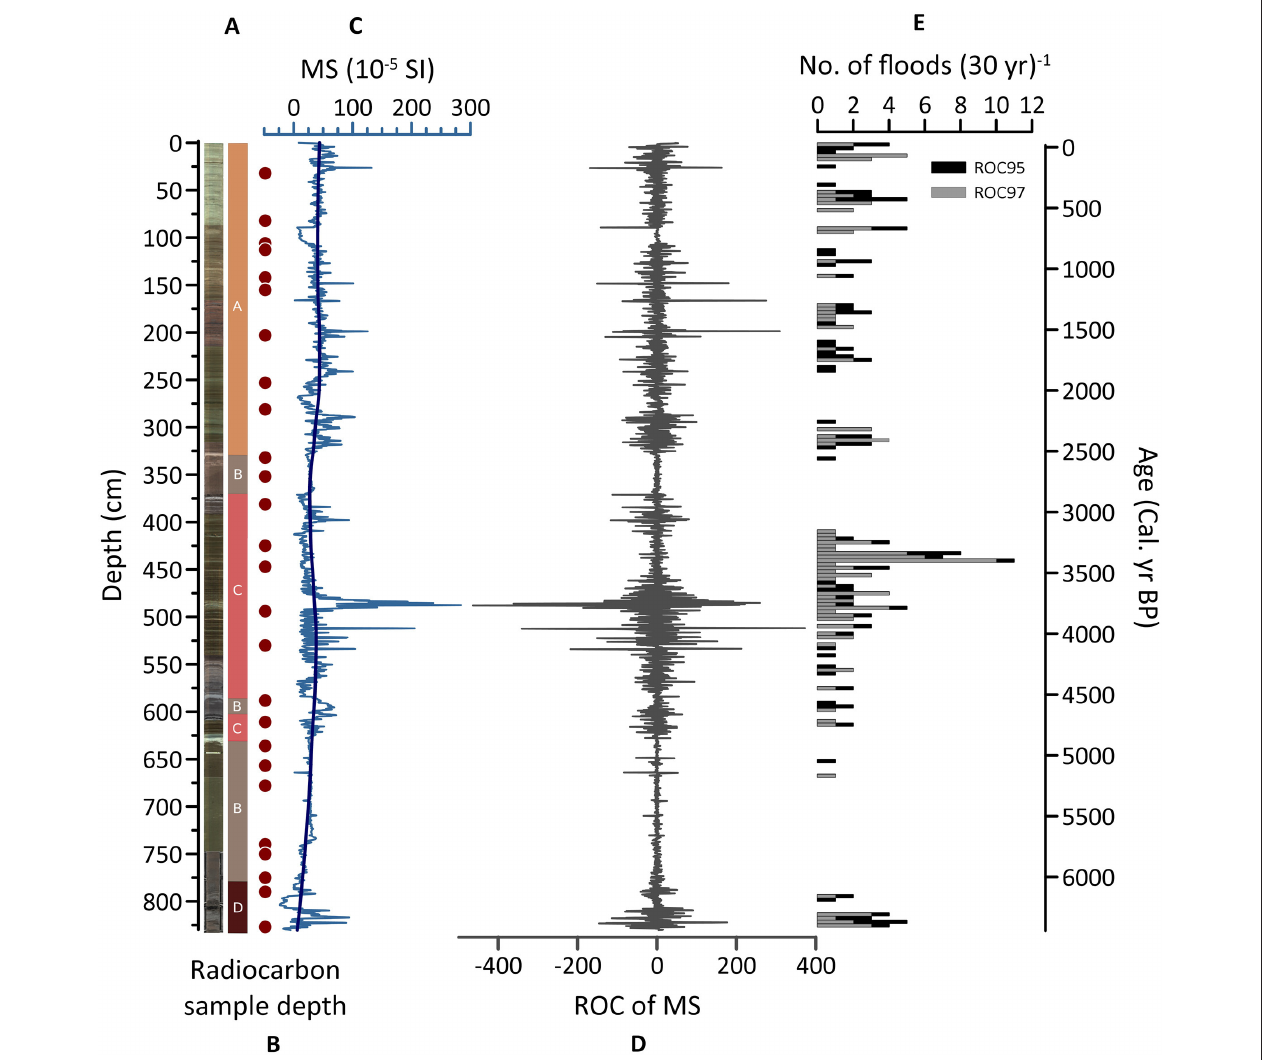
FIGURE 5 | (A) Surface image of SA16/17 shown together with unit divisions (A–D) . (B) Sampling depth for radiocarbon ( 14 C) dates (red dots). (C) Magnetic susceptibility (MS, 10 − 5 SI) for the whole core plotted together with a superimposed trend line (quadratic Gaussian LOESS fit). (D) Rate of change (ROC) of MS (calculated on depth scale), which is presented in column C. (E) Flood reconstruction plotted against the age axis to the right. Each bar represents the number of floods per one 30 year period. The reconstruction of extreme floods is based on values crossing the 95th percentile of ROC based on the MS values ( D ; black bars). For comparison, the reconstruction was also made with values above the 97th percentile (gray